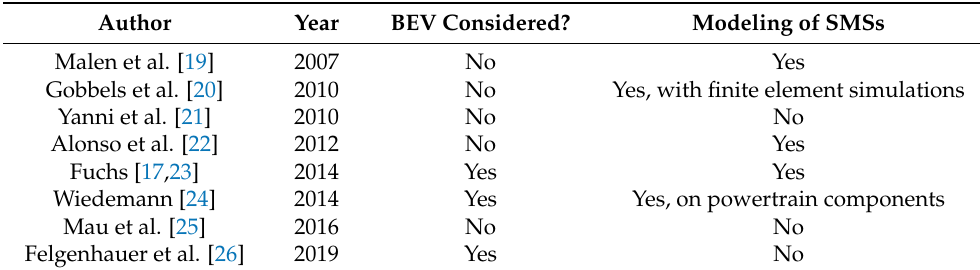
Table 1. Overview of existing methods of vehicle mass estimation. Based on